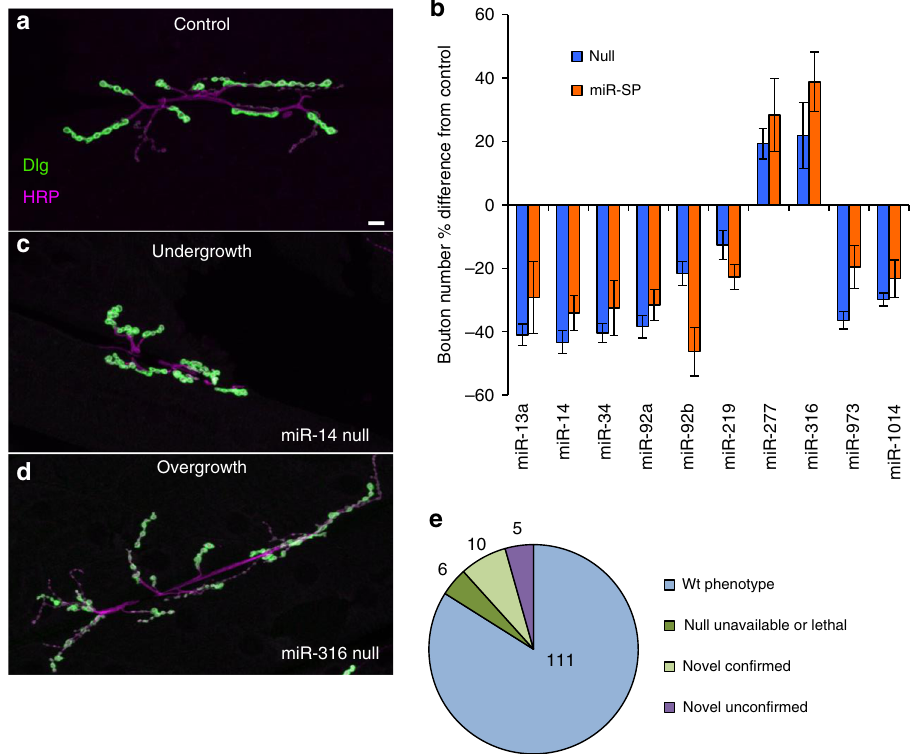
Fig. 1 In vivo screen of miRNA regulatory complexity in the Drosophila NMJ. a , c , d Scanning confocal images of NMJ arbors at larval muscles 6 and 7 (L3 segment A2) are shown stained for the presynaptic membrane (HRP, magenta), and postsynaptic cytomatrix (Dlg, green); scale bar (10 µ m) applies to all panels. Representative phenotypes from the screen are shown, including a w 1118 control, c miR-14 null undergrowth, and d miR-316 null overgrowth. b Bouton number phenotypes that reached or exceeded signi fi cance ( p ≤ 0.05) are shown as a percentage change (Error bars indicate + SEM) relative to matched control for GenII miR-SP driven ubiquitously using a tubulin-GAL4 driver (orange bars; tubulin-GAL4,Scramble-SP is the control genotype at 122.4 + 11 SEM; sample depth of n = 10 hemisegments) or as con fi rmed by subsequent analysis of miRNA null alleles (blue bars; w 1118 is the control genotype at 123.7 + 8.75 SEM; sample depth of n = 10 hemisegments, except in the cases of miR-219 and miR-277 that were sampled and n = 20). All results shown were analyzed by ANOVA. Two tailed T -test and show p -values ≤ 0.05 (see Supplementary Data 1 for screen data). e Summary of bouton number defects observed in the miR-SP ubiquitous competitive inhibition assay, relative to novel phenotypes con fi rmed with null alleles (see key for categories). Source data are provided as a Source Data fi